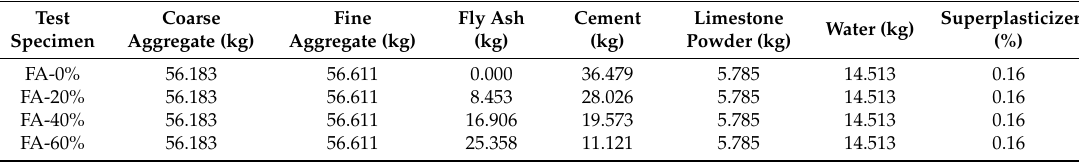
Table 3. Mix details of SCCs in this test.